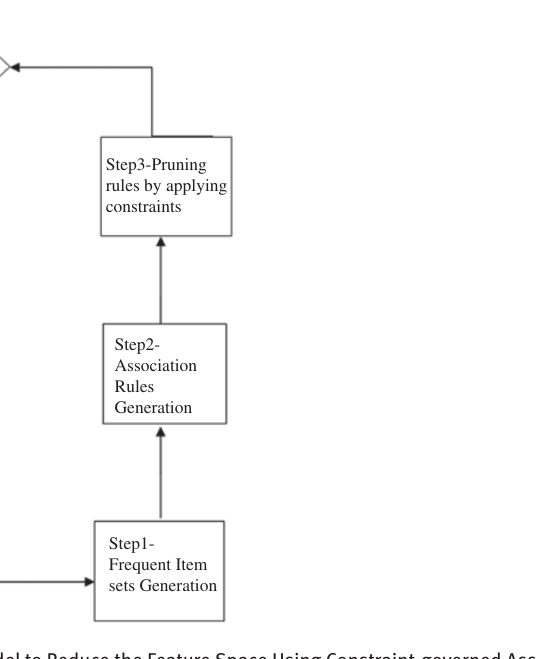
Figure 1: Flow Chart of the Proposed Model to Reduce the Feature Space Using Constraint-governed Association Rule